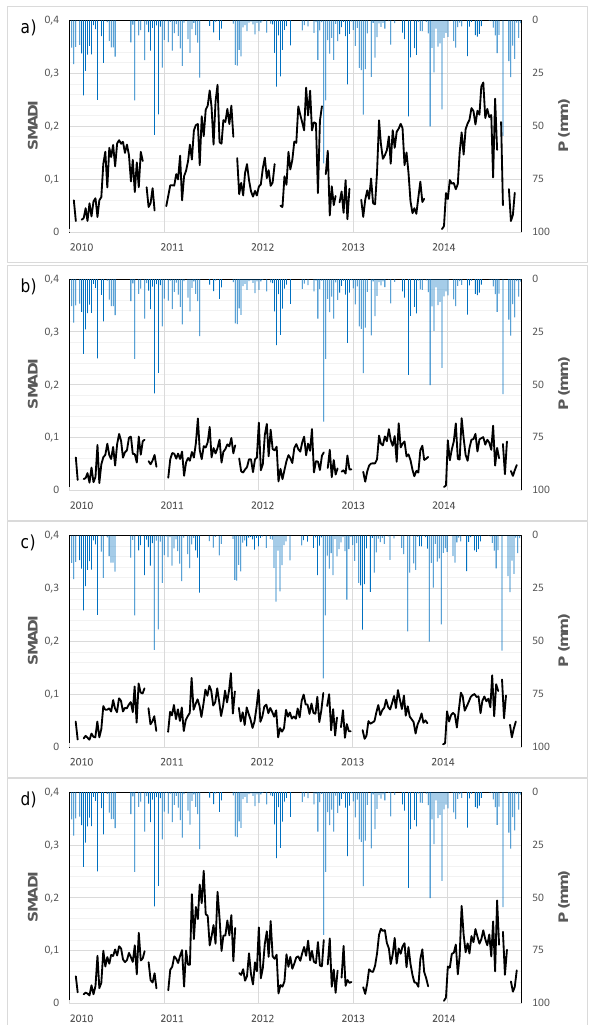
Figure 5. SMADI results at REMEDHUS scale for (a) NDVI, (b) NDWI-1240, (c) NDWI-1640 and (d) NDWI-2130 versions. Only MTCI-day alternative is shown.